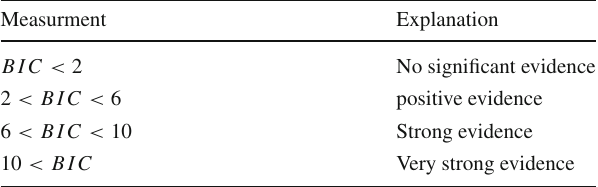
Table 3 The level depiction of evidence against models from